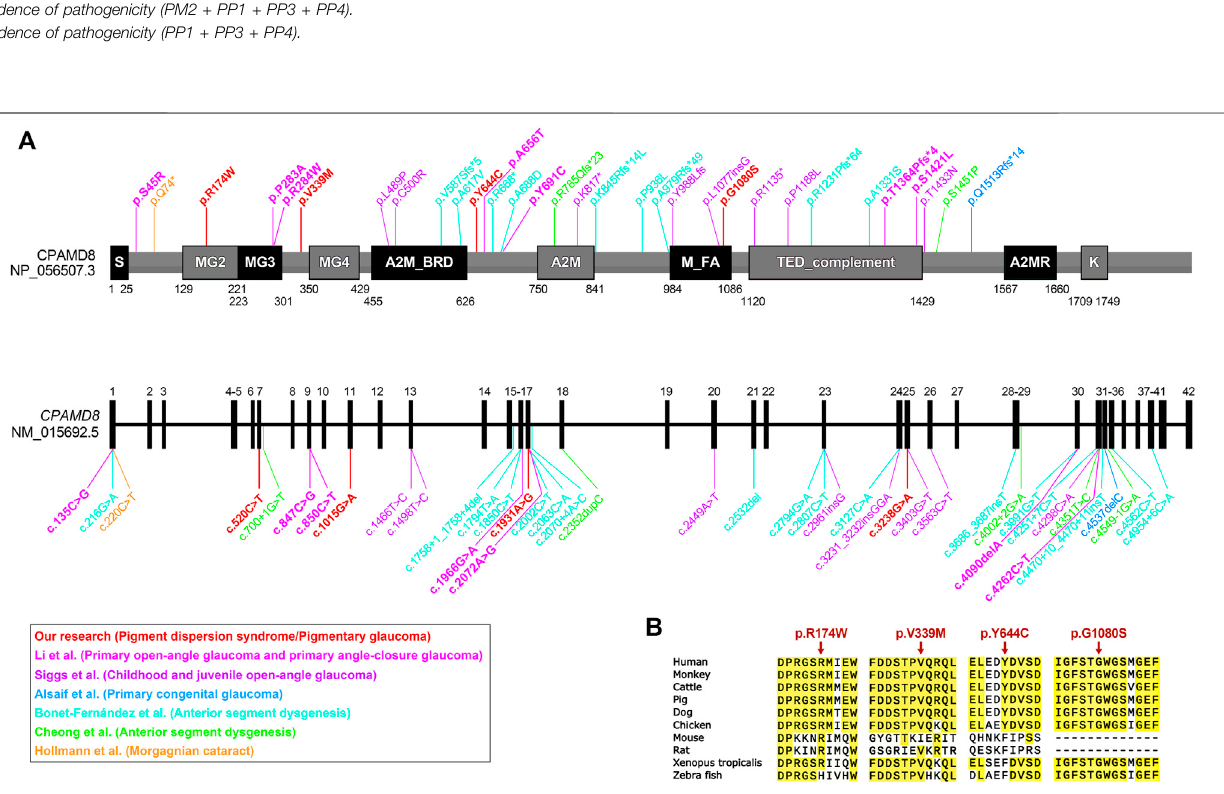
Frontiers in Genetics |